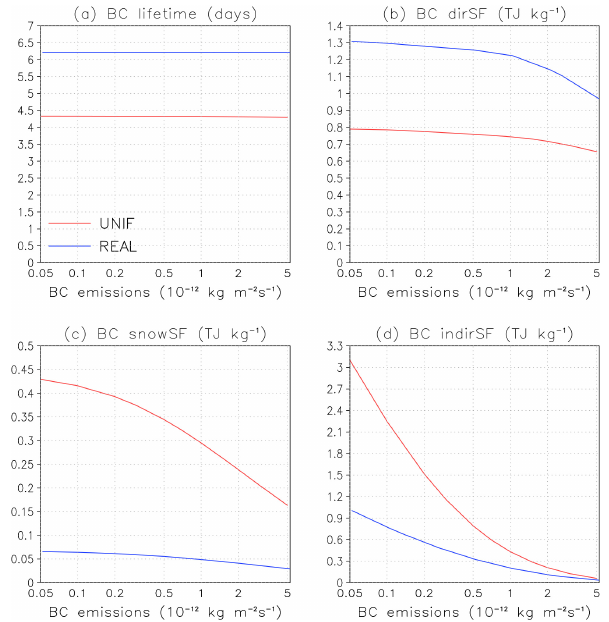
Figure 8. Global annual mean values of (a) BC lifetime (in d), (b) BC direct specific forcing, (c) BC snow specific forcing, and (d) BC indirect specific forcing (TJkg − 1 ) for the experiments in which the spatiotemporal distribution of emissions was fixed but their mag- nitude was varied between roughly 0.1 and 10 times the present- day value. The experiments with uniform (UNIF) BC emissions are shown with red lines and those with a realistic spatiotemporal emis- sion distribution (REAL) with blue